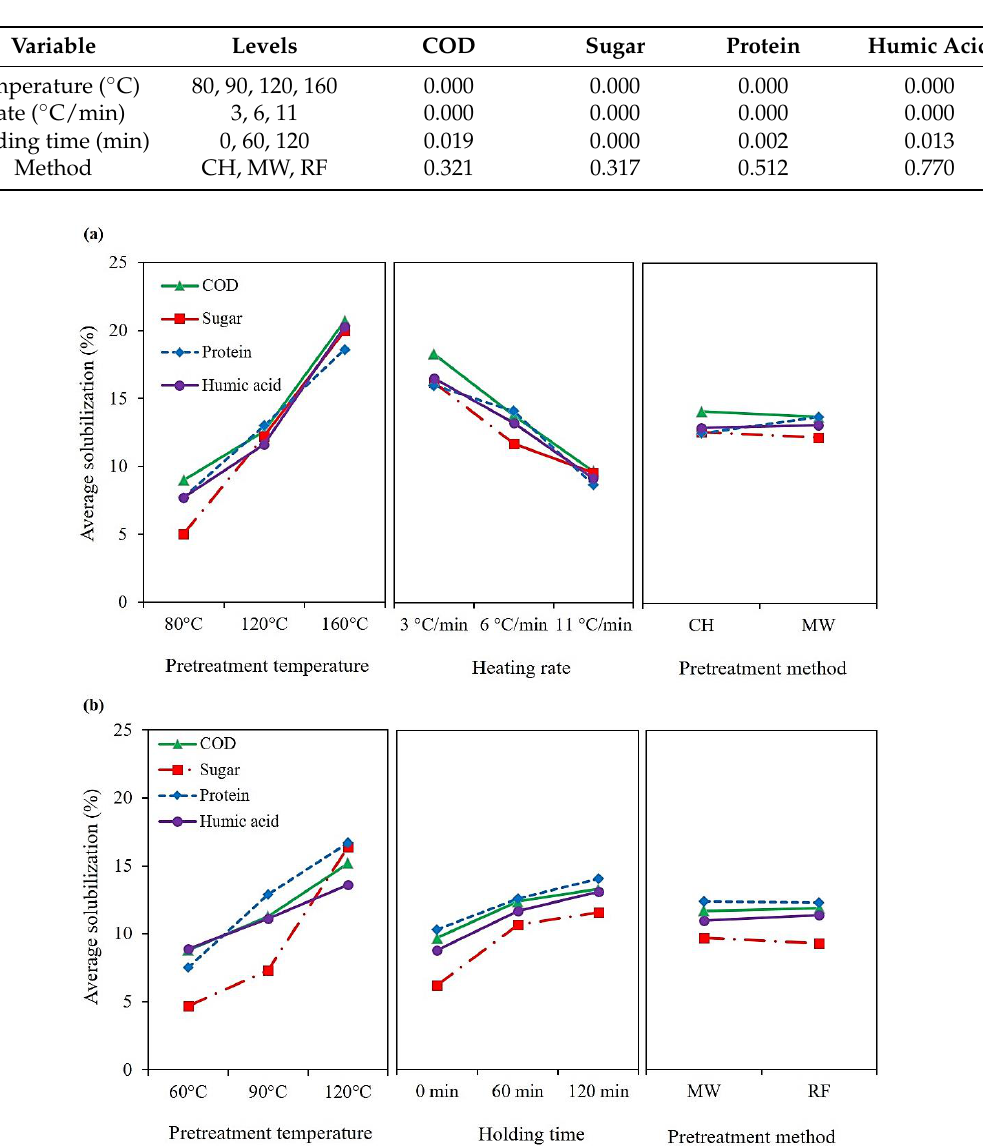
Figure 2. The main effect plot of COD, sugar, protein, and humic acid solubilization from; ( a ) CH vs. MW study; ( b ) MW vs. RF study.